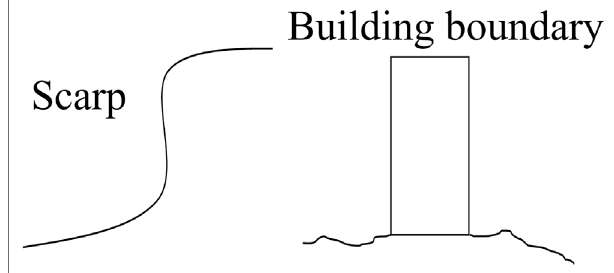
FIGURE 5 | Judgement of elevation